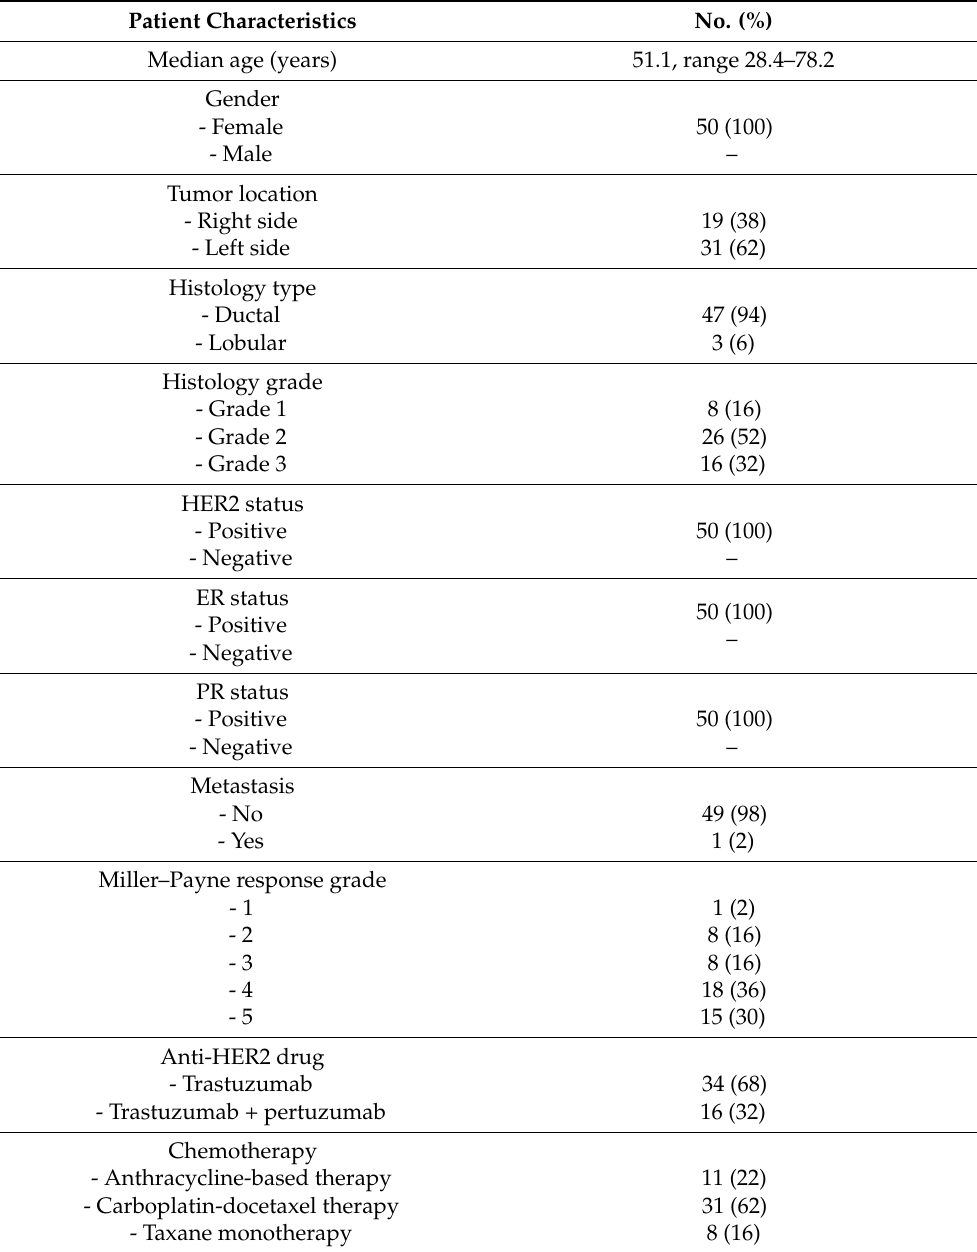
Table 1. Baseline characteristics of the 50 patients enrolled in this